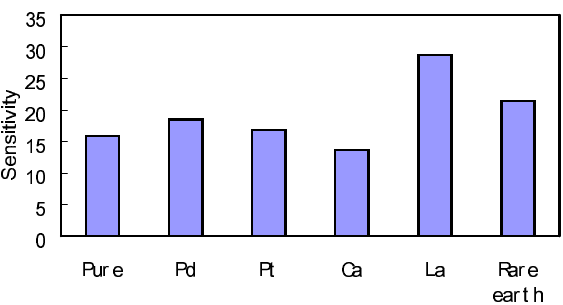
Figure 4. The sensitivities of ITO thin film gas sensors with different adulterant (*Rare earth is the mixture of La, Ce, Sm, Eu and Er).